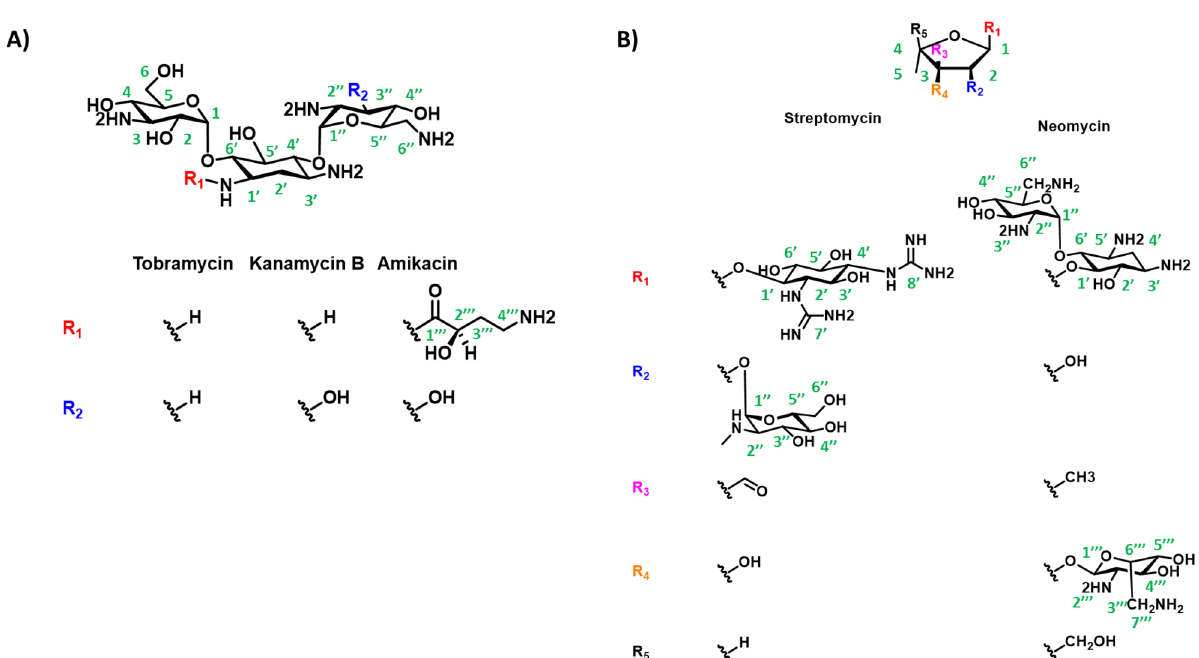
Figure 2. ( A ) Trisaccharide and ( B ) pentose scaffold of aminoglycoside inhibitors explored in this work with carbons labeled in